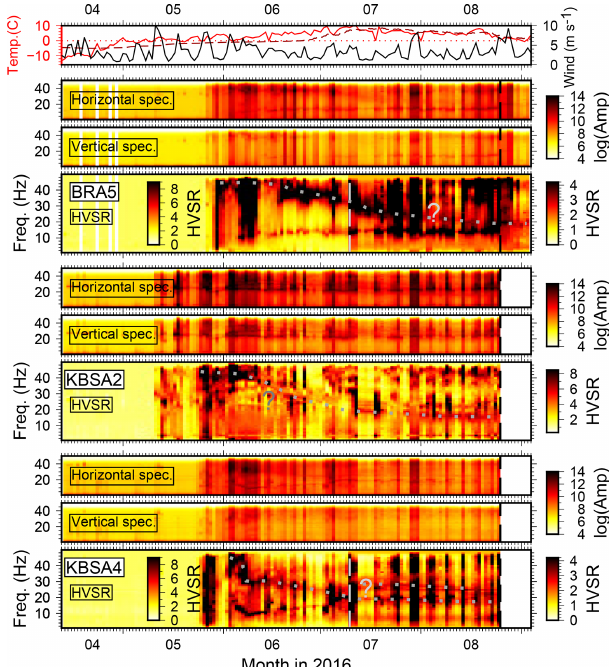
Figure 3. Same as Fig. 2 for three more stations. The gray dashed vertical line indicates change of color scale on 10 July. Color scale is clipped at high HVSRs (black) for BRA5 and KBSA4 to enhance visibility of the weak gliding peak on days of low wind speed. The scale used before 10 July is provided to the